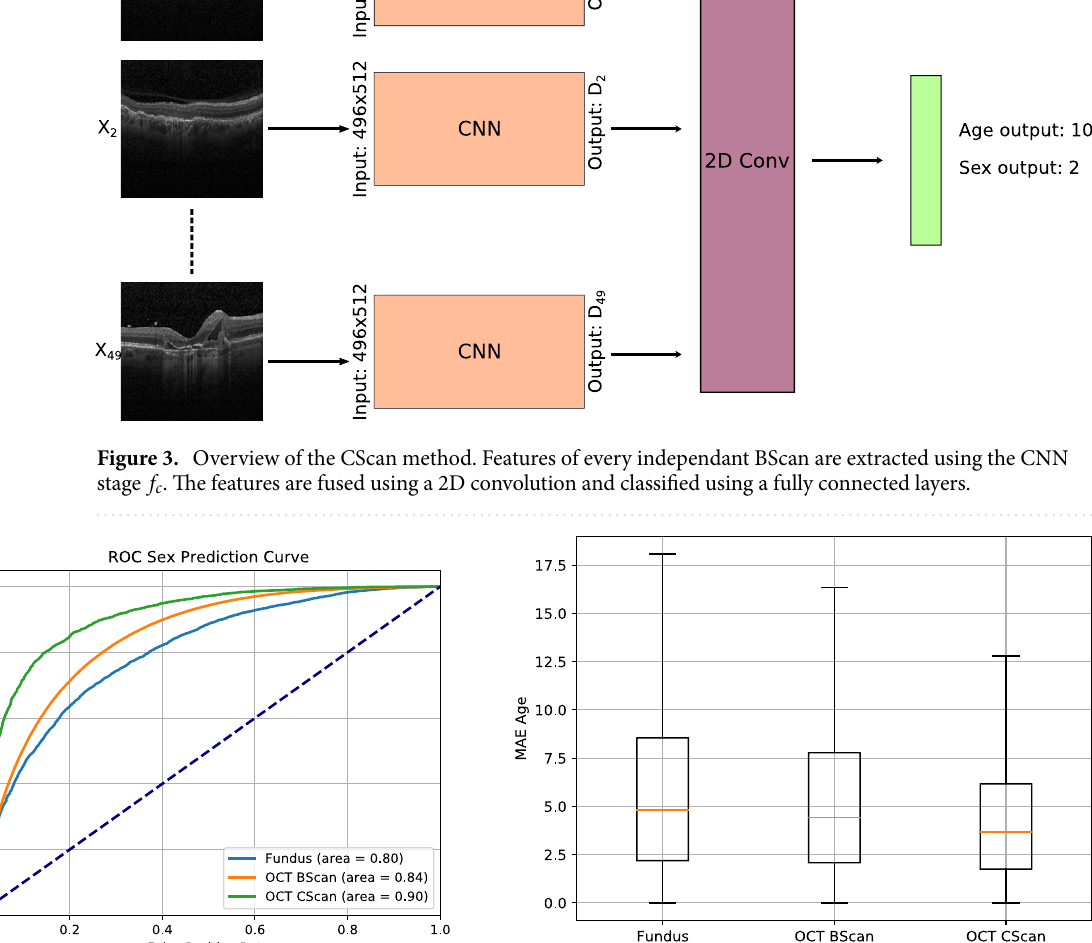
Figure 4. Results of automated age and sex prediction compared by